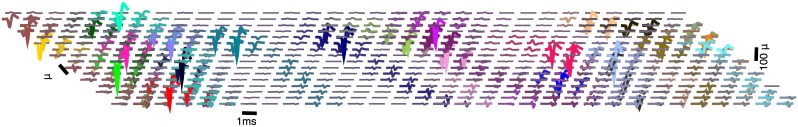
Overlapping electrical images of 24 neurons (different colors) over the MEA, aligned to onset of spiking at t = 0.5ms.Each trace represents the time course of voltage at a certain electrode. For each neuron, traces are only shown in the electrodes with a strong enough signal. Only a subset of neurons visible on the MEA are shown, for better visibility.